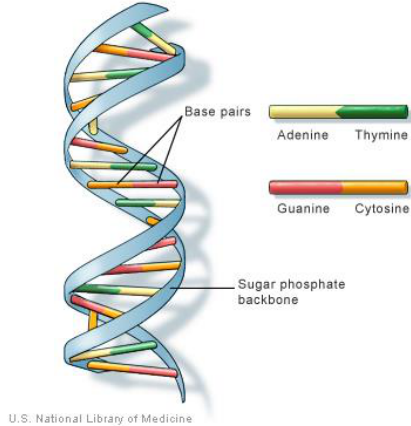
Figure 1. DNA model in biology